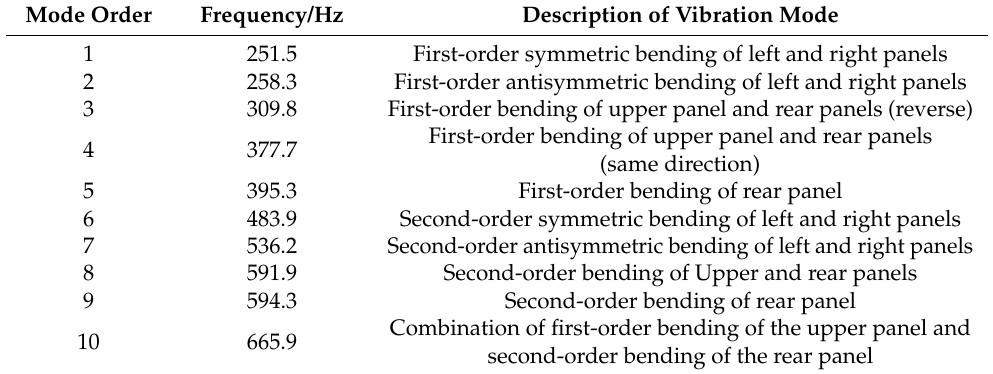
Table 3. Low-order mode analysis results of the electrical control box.